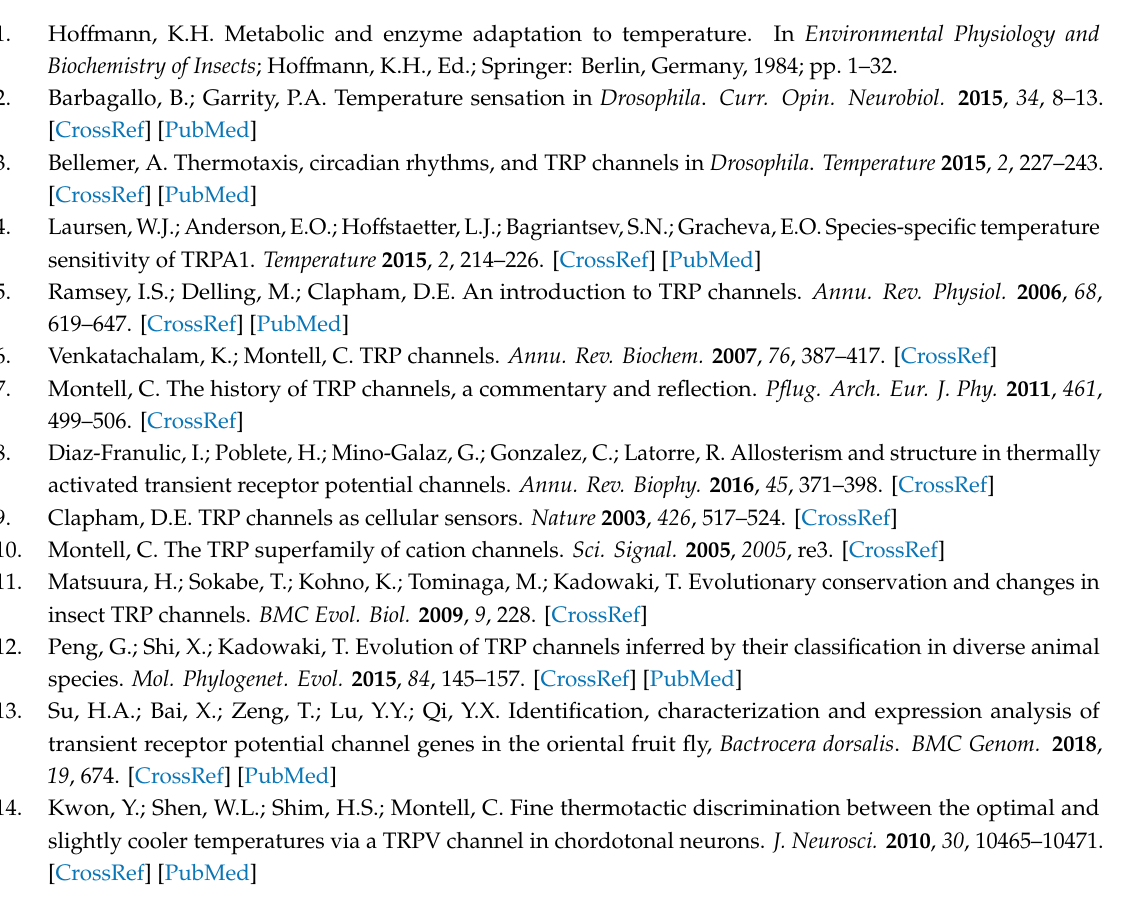
Figure S1: Putative amino acid sequence of AhTRPA1. Numbers on the left indicate the locations of amino acid residues. Shaded areas represent the predicted ankyrin repeats (Ank1–Ank14). Framed sequences were the predicted transmembrane segments (S1–S6), Figure S2: Putative amino acid sequence of AhPainless. Numbers on the left indicate the locations of amino acid residues. Shaded areas represent the predicted ankyrin repeats (Ank1–Ank7). Framed sequences were the predicted transmembrane segments (S1–S6), Figure S3: Putative amino acid sequence of AhPyrexia. Numbers on the left indicate the locations of amino acid residues. Shaded areas represent the predicted ankyrin repeats (Ank1–Ank8). Framed sequences were the predicted transmembrane segments (S1–S6), Table S1: Primers used for RT-PCR cloning of the full-length cDNA sequences of AhTRPA1 , AhPailess , AhPyrexia and qPCR analysis of their expression, Table S2: The accession numbers of all TRPs used in phylogenetic